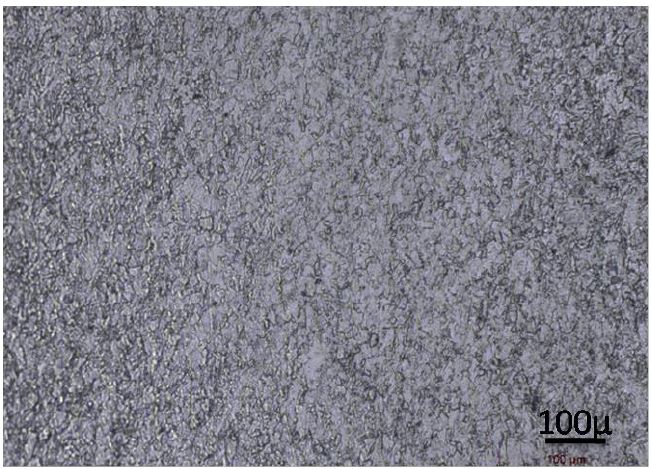
Fig. 2. Optical micrograph of the retrieved implant 4.